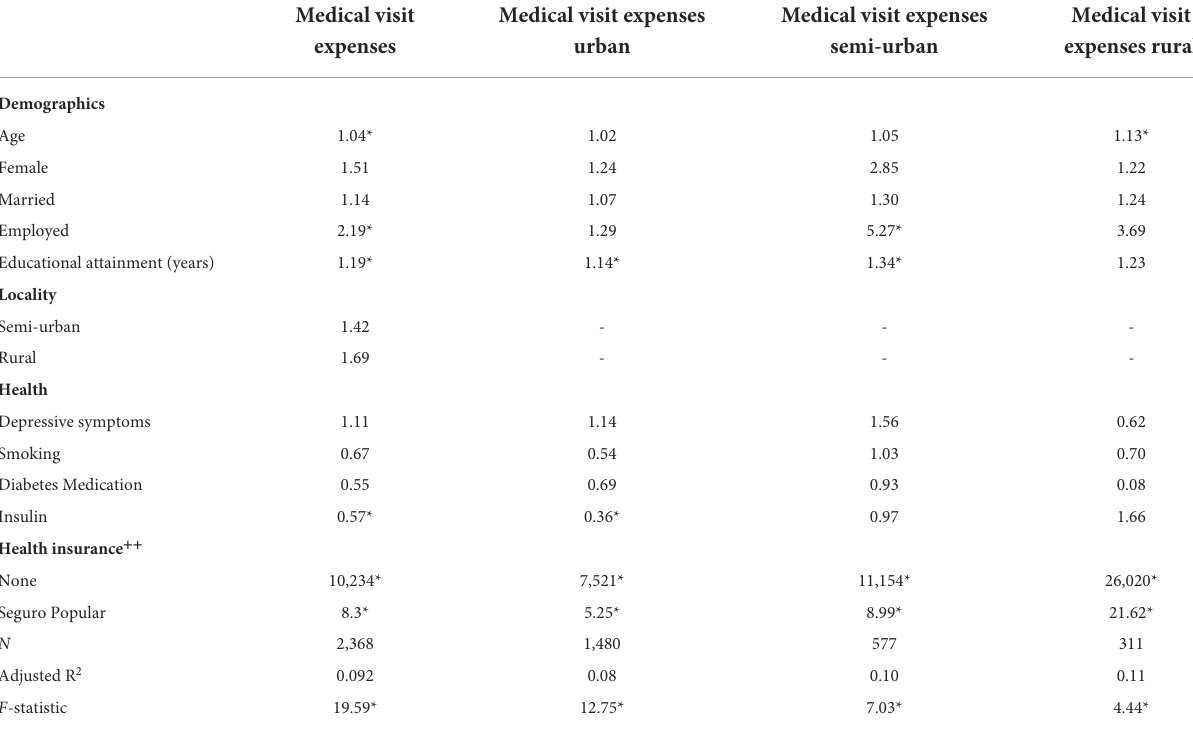
TABLE 3 Average effects of out-of-pocket medical visit expenses by